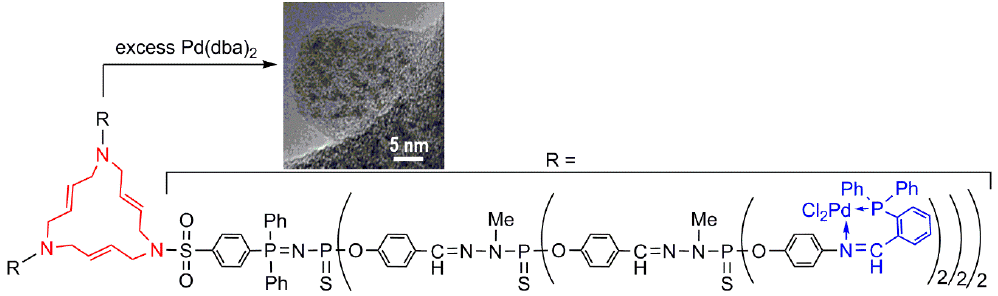
Figure 3. Dendrimer having complexes of P,N ligands and PdCl 2 as terminal functions and a